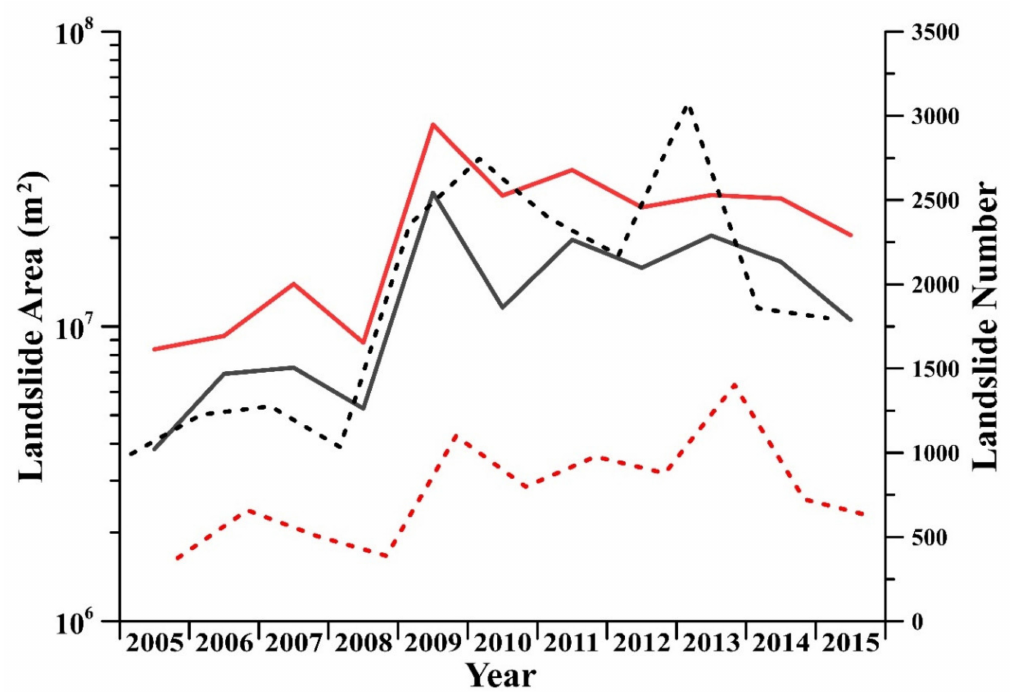
Figure 6. The area (solid line) and number (dash line) of landslide in the ARW (black) and TRW (red) from 2005 to